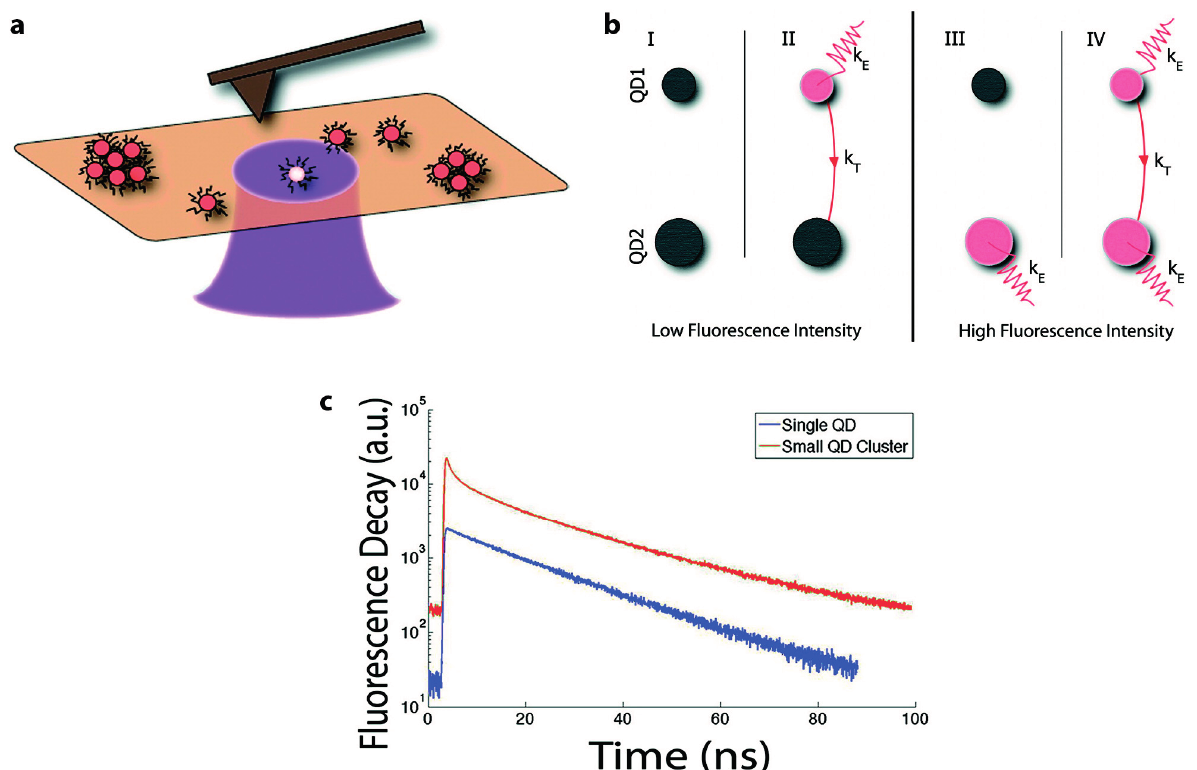
Figure 6. ( a ) Schematic of correlated fluorescence and atomic force microscopy on single QDs and QD clusters; ( b ) Schematic of possible emission and energy transfer schemes accounting for independent blinking (on/off states) of a QD donor (QD1) or acceptor (QD2); ( c ) Time-resolved PL of a single QD and a small QD cluster. Schematics are not drawn to scale. Reprinted with permission from [77]. Copyright (2010) American Chemical